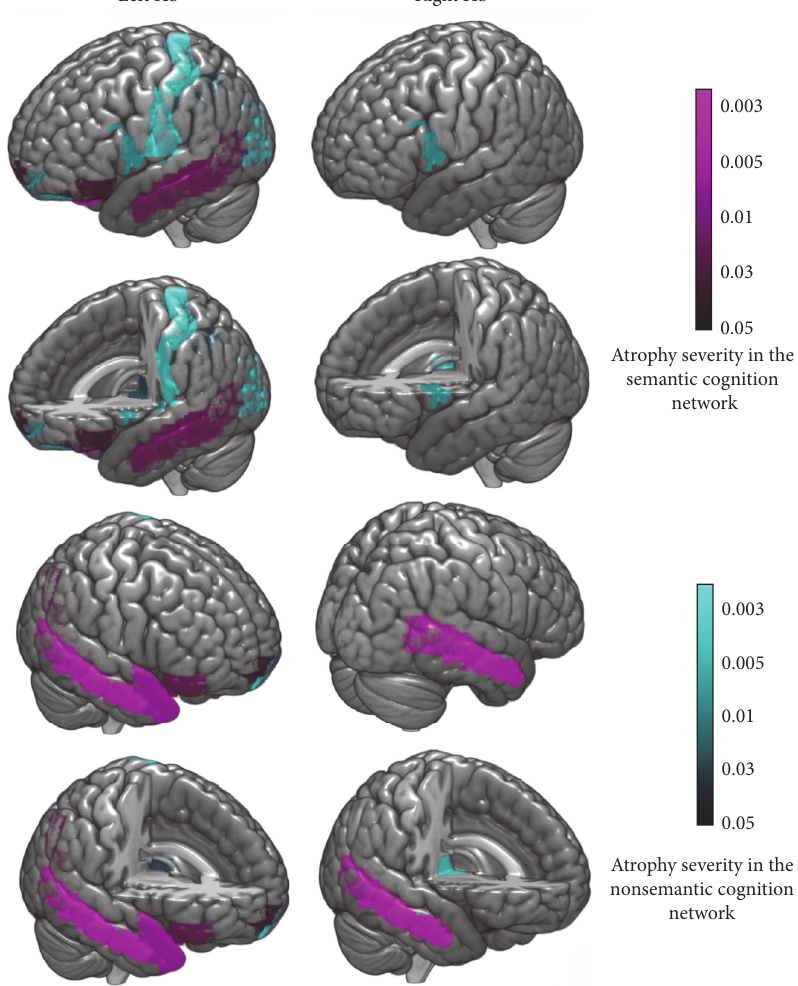
Figure 1: Gray matter volume (GMV) loss of patients with left HS or right HS (FWE corrected, 𝑝 = 0.05 ; minimum cluster size 10). In the left HS subgroup, GMV loss was observed in 12 ROIs in the ipsilateral lobe (including the IFG, vmPFC, hippocampus, and MTG in the semantic cognition network) and 7 ROIs in the contralateral lobe (including the IFG, vmPFC, parahippocampus, fusiform, AG, tpSTG, tpMTG, and MTG, all of which were components of the semantic cognition network); in the right HS subgroup, GMV loss was seen in 2 ROIs in the ipsilateral lobe and the MTG in the contralateral